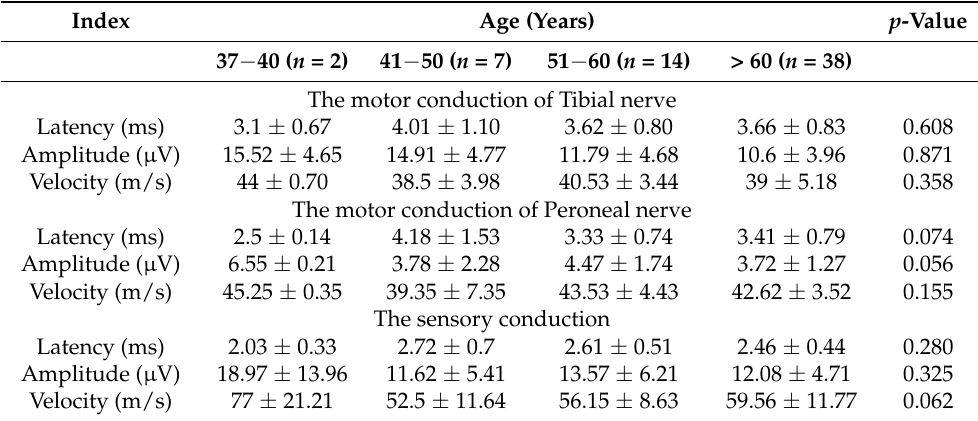
Table 3. Mean values of the motor/the sensory conduction parameters of the tibial nerve and of the peroneal nerve by age